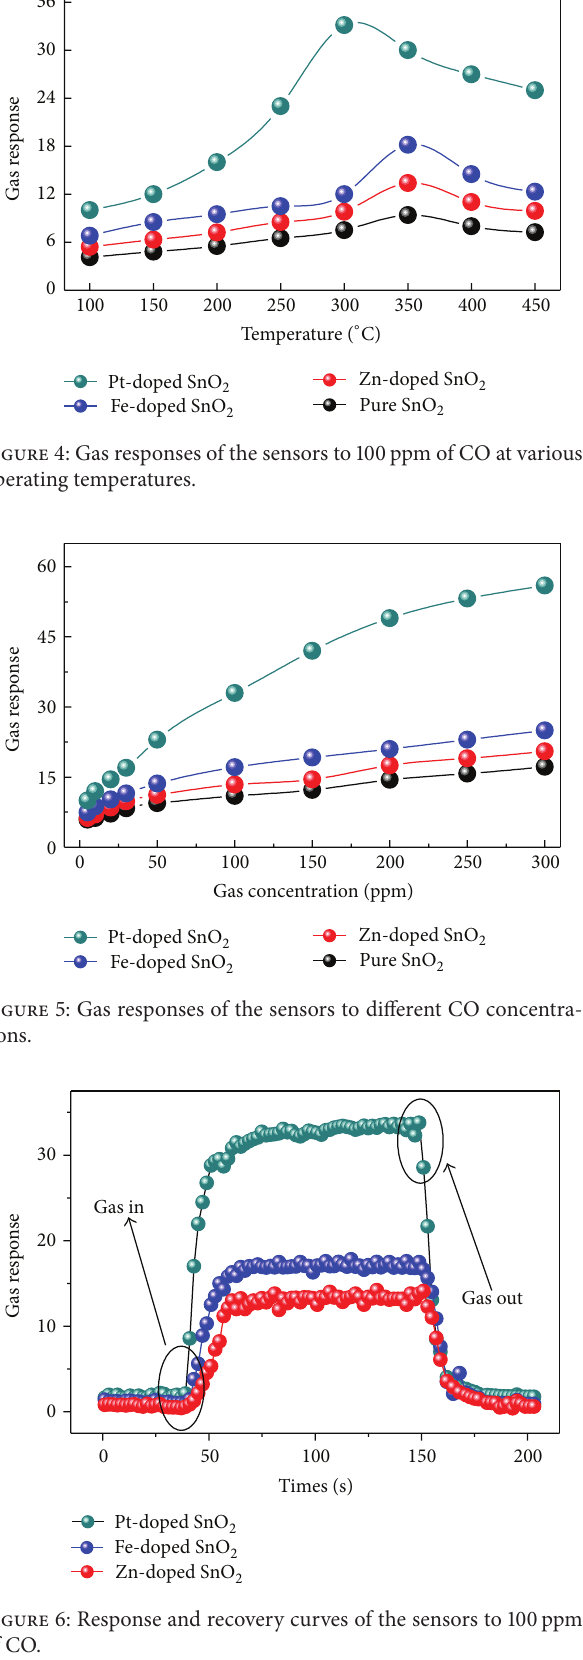
Figure 6: Response and recovery curves of the sensors to 100ppm of CO.